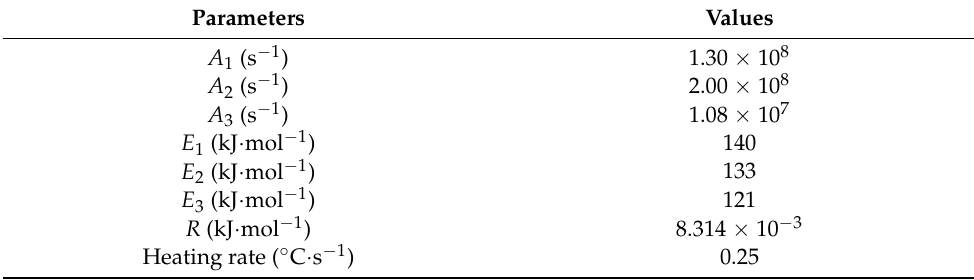
Table 1. Primary kinetic data and other constants that are used in the